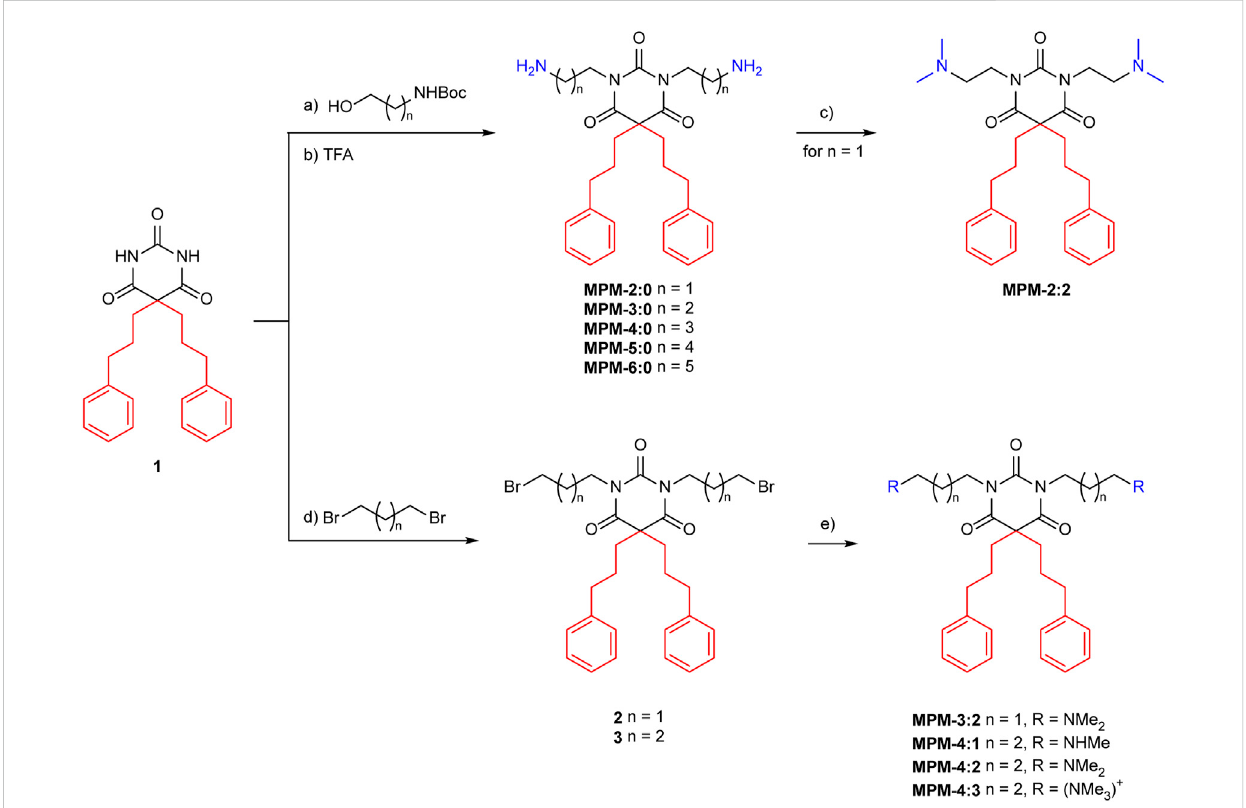
Scheme 1 Synthesis of the MPMs. Conditions: (A) DIAD, PPh 3 , anhydrous DCM, 0 ° C to r.t.; (B) TFA, DCM, r.t., 51% – 93% o2s; (C) formaldehyde (37% (aq) ),